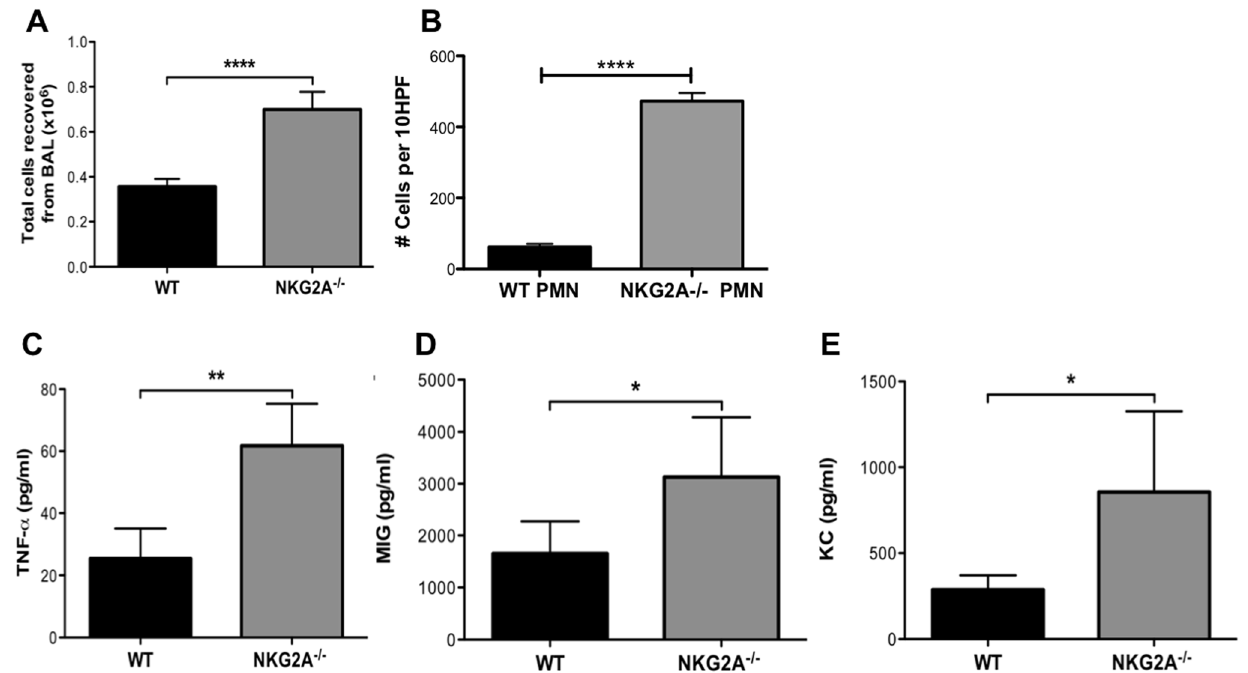
Figure 6. NKG2A 2 / 2 mice have increased cellularity and inflammatory cytokines at 10 days p.i. Influenza PR8 infection than WT mice. Mice were intranasally infected with a sub-lethal dose of influenza A/PR8/34. On day 10 post-infection, cells were recovered from the BAL and the (A) total number of cells was enumerated. Cytospin preparations from BAL were examined for PMN (B). BALF concentrations for (C) TNF- a , (D) MIG, and (E) KC on day 10 post-infection were determined by Multiplex assay. Data are representative of two independent experiments of 5 mice per group. * p , 0.05, ** p , 0.01, and *** p , 0.005.